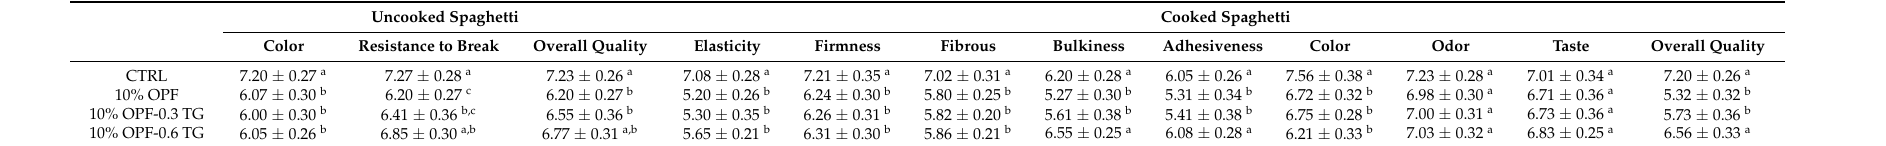
Table 3. Sensory characteristics of uncooked and cooked dry spaghetti samples investigated in the Step 3.